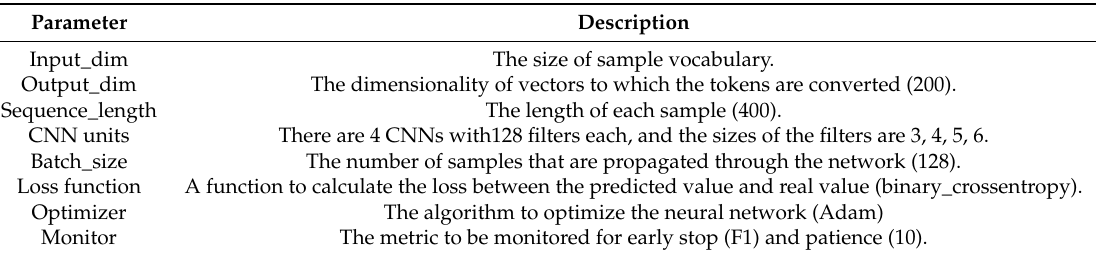
Table 2. Tuned parameters for representation